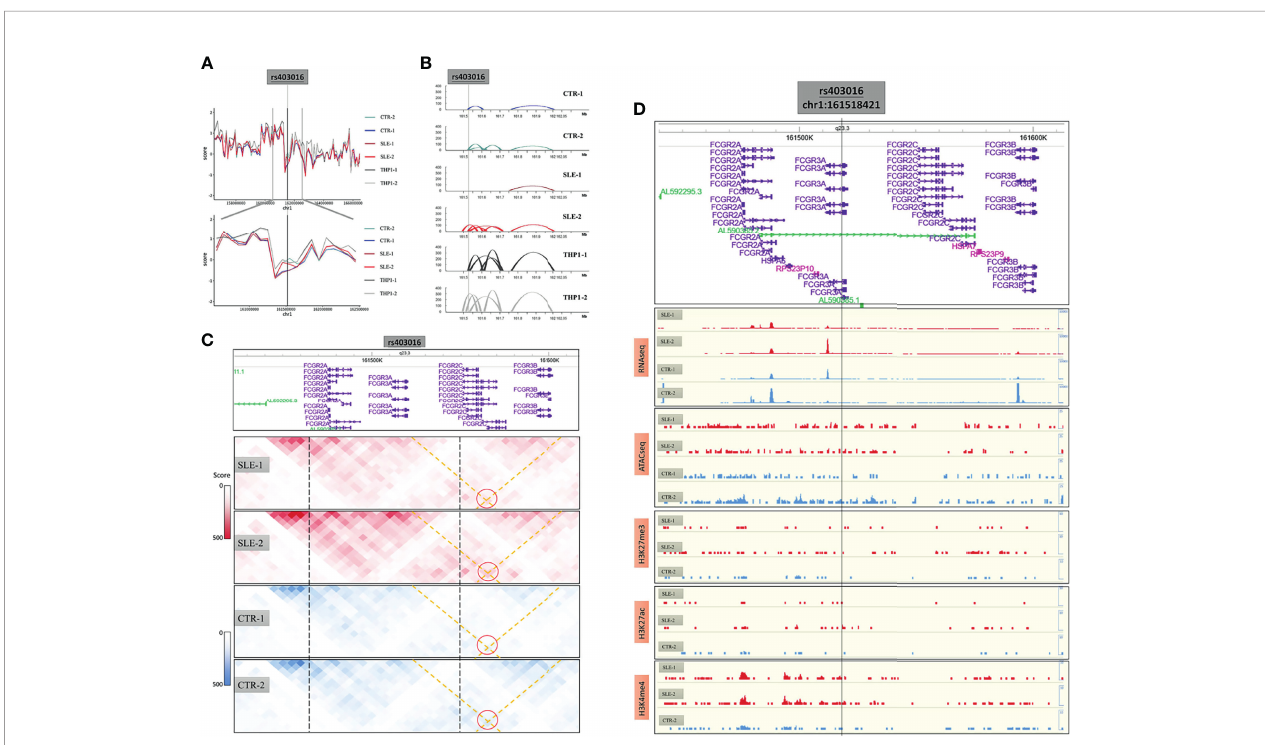
FIGURE 6 | The 3D structure around CD16 coding gene. (A) The insulation score value of six samples around CD16 coding genes. (B) The loops of six samples around this region. (C) The chromatin interactions around this region. (D) The results of RNA-seq, ATAC-seq and ChIP-seq of H3K27me3, H3K27ac and H3K4me4 around this region.